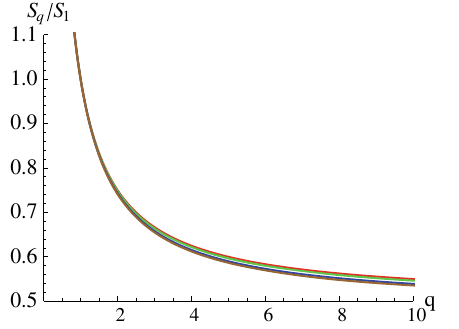
Fig. 1 S q / S 1 as a function of q for various C . Here d = 2 and red, green, blue and brown curves correspond to C = 0, − 1 / 2, − 3 / 2 and − 2, respectively